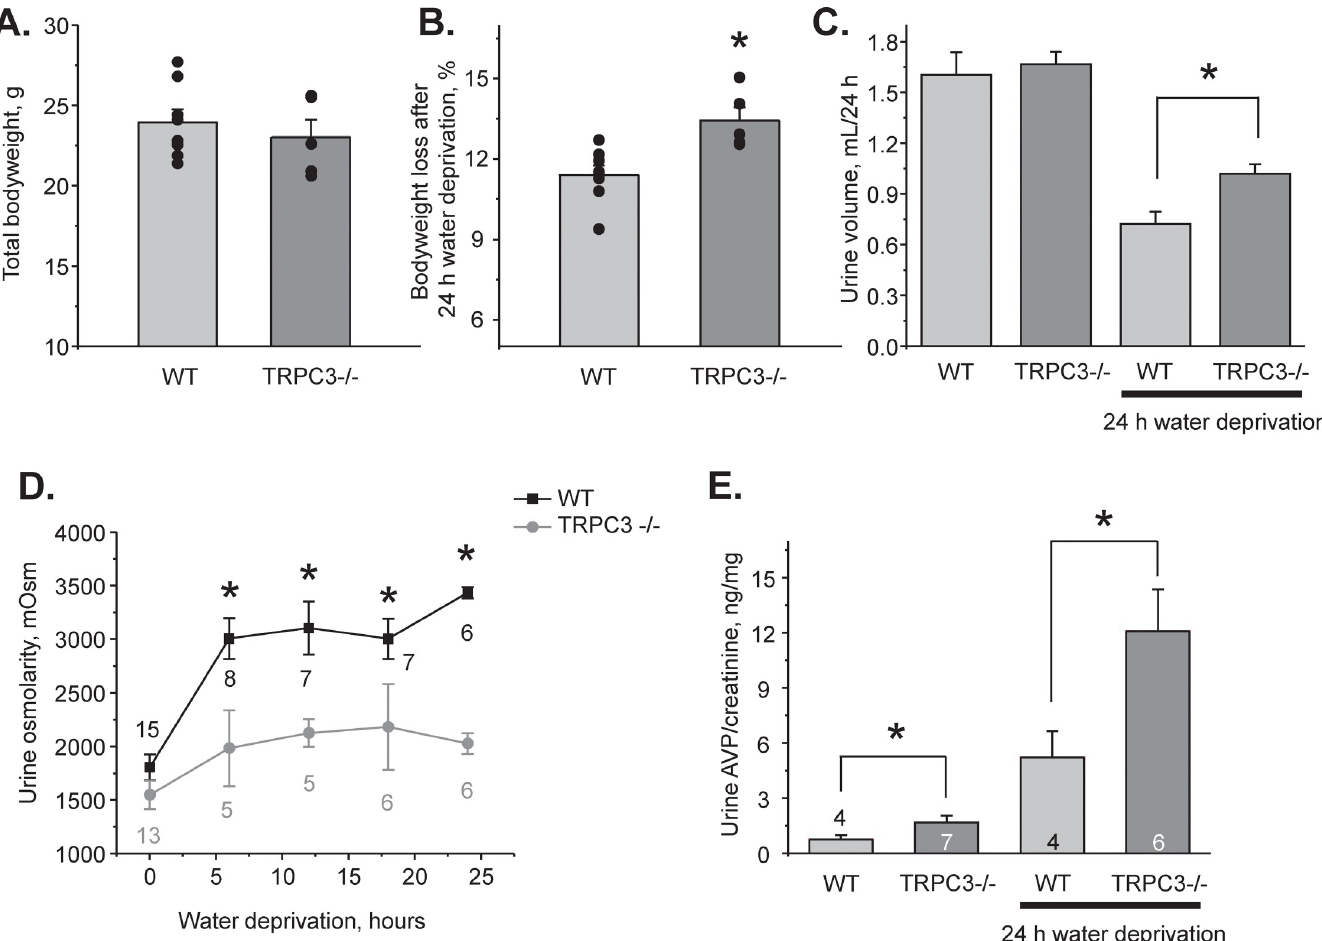
Fig 4. TRPC3 -/- mice develop urinary concentrating defect. (A) Summary graph comparing whole body animal weight of WT and TRPC3 -/- mice used for metabolic cage balance studies. (B) Summary graph of weight loss induced by 24h water deprivation in WT and TRPC3 -/- mice. (C) Summary graph comparing 24h urinary output in WT and TRPC3 -/- mice placed in metabolic cages in the control and after 24h water deprivation. (D) Summary graph comparing urinary osmolarities at the baseline and during 6, 12, 18, and 24 hour water deprivation in WT and TRPC3 -/- mice. (E) Summary graph of urinary arginine vasopressin (AVP) levels in WT and TRPC3 -/- mice at the baseline and after 24h water deprivation. AVP levels were normalized on the respective urinary creatinine concentrations. Number of tested animals for each experimental time-point is shown. � —significant change versus respective values in WT